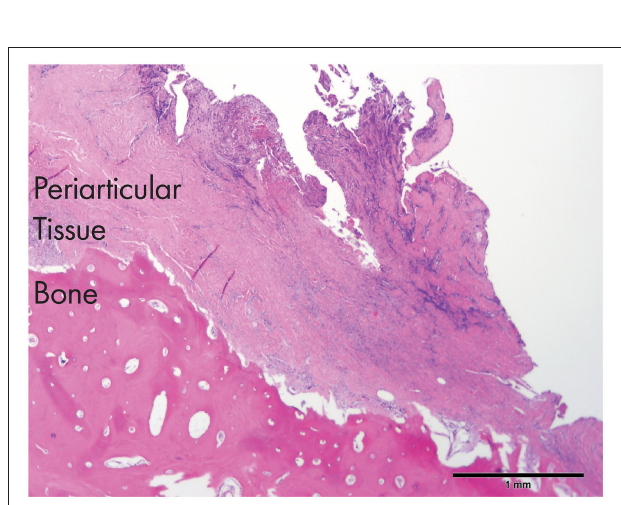
FIGURE 5 | An histological section of the tissues obtained from dog 3. Note the severely inflamed periarticular tissues and the necrotic bone (zygomatic arch) in the proximity of the affected TMJ [H&E staining and Bar =